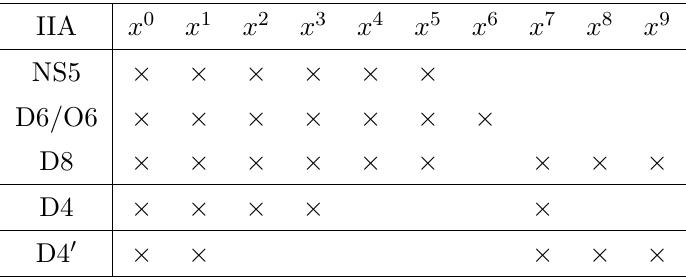
Table 1. The Type IIA brane configuration for the 6d N = (1 , 0) SO( N c ) theories with N f = N c − 8 flavors and one tensor multiplet. Here × denote directions filled by the various branes and O6- planes. The codimension 2 defect is realized by the D4-brane; while the D 4 0 -brane introduces a codimension 4